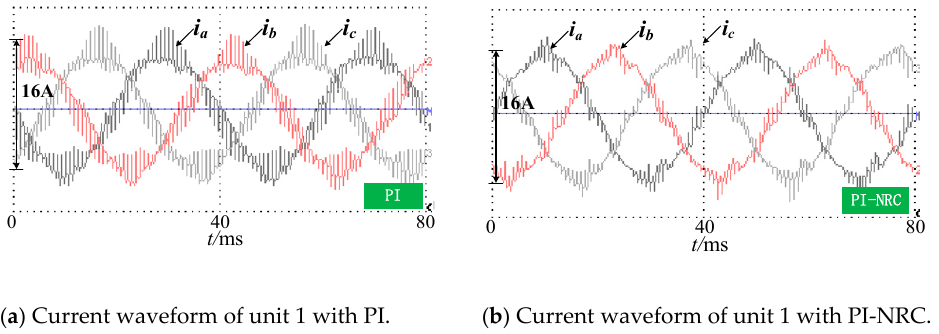
Figure 15. No-load EMF of a 6* three-phase PMSG Prototype.